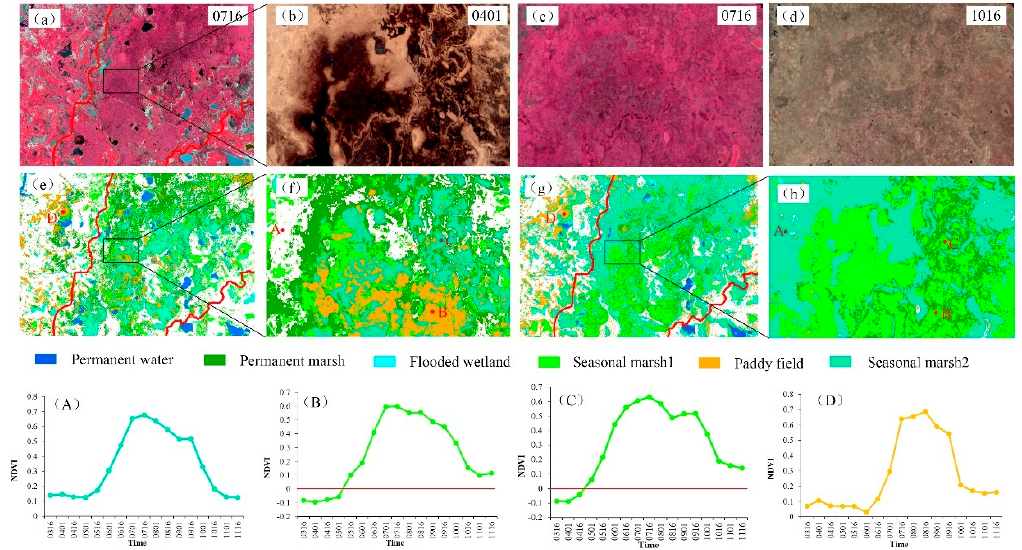
Figure 6. Comparison between our resultant wetland map and the classification result based on optimal features and the RF algorithm. ( a ) Location of the first subset in our study area (false colour image created from 15-day Sentinel-2 composited image between 16 and 31 July). ( b ) False colour image for the first subset (15-day Sentinel-2 composited image between 1 and 15 April). ( c ) False colour image for the first subset (15-day Sentinel-2 composited image between 16 and 31 July). ( d ) False colour image for the first subset (15-day Sentinel-2 composited image between 16 and 31 October). ( e , f ) Wetland mapping result using seasonal-rule-based wetland classification method. ( g , h ) Wetland mapping result using the Random Forest algorithm. ( A – D ) 15-day Sentinel-2 composited NDVI time series curves for point A, B, C, and D in ( e – h ). Note: The times marked in the figure are the first dates of the 15-day Sentinel-2 composite images.